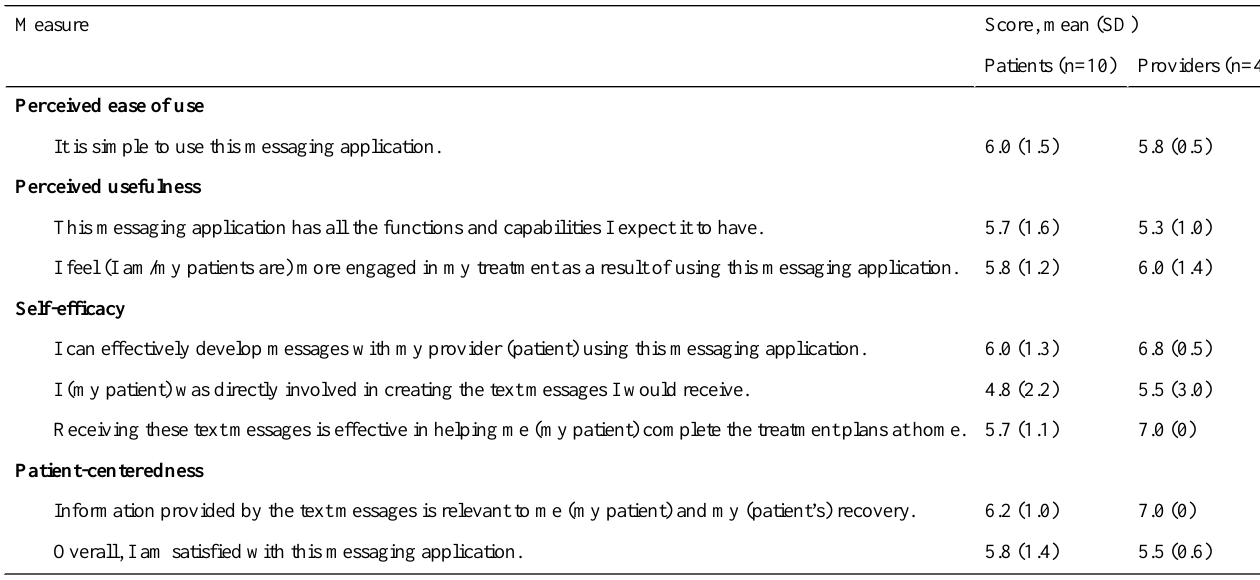
Table 1. Usability and satisfaction with the Chorus platform and mobile texting apps.